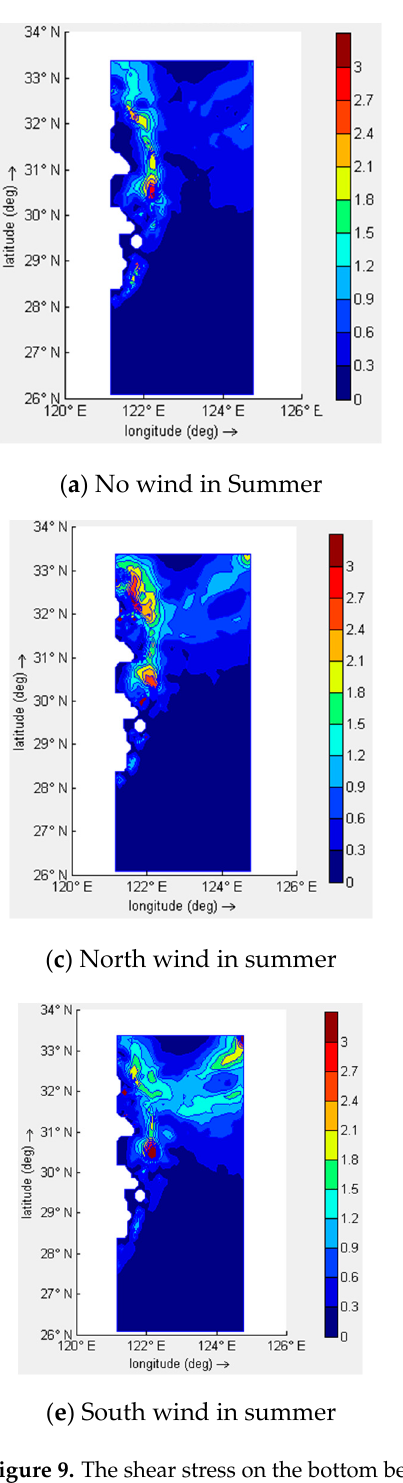
Figure 9. The shear stress on the bottom bed at the Yangtze River Delta under no wind ( a ), east wind ( b ), north wind ( c ), west wind ( d ), south wind ( e ) in summer and north wind ( f ) in winter (Unit: Pa) [30].